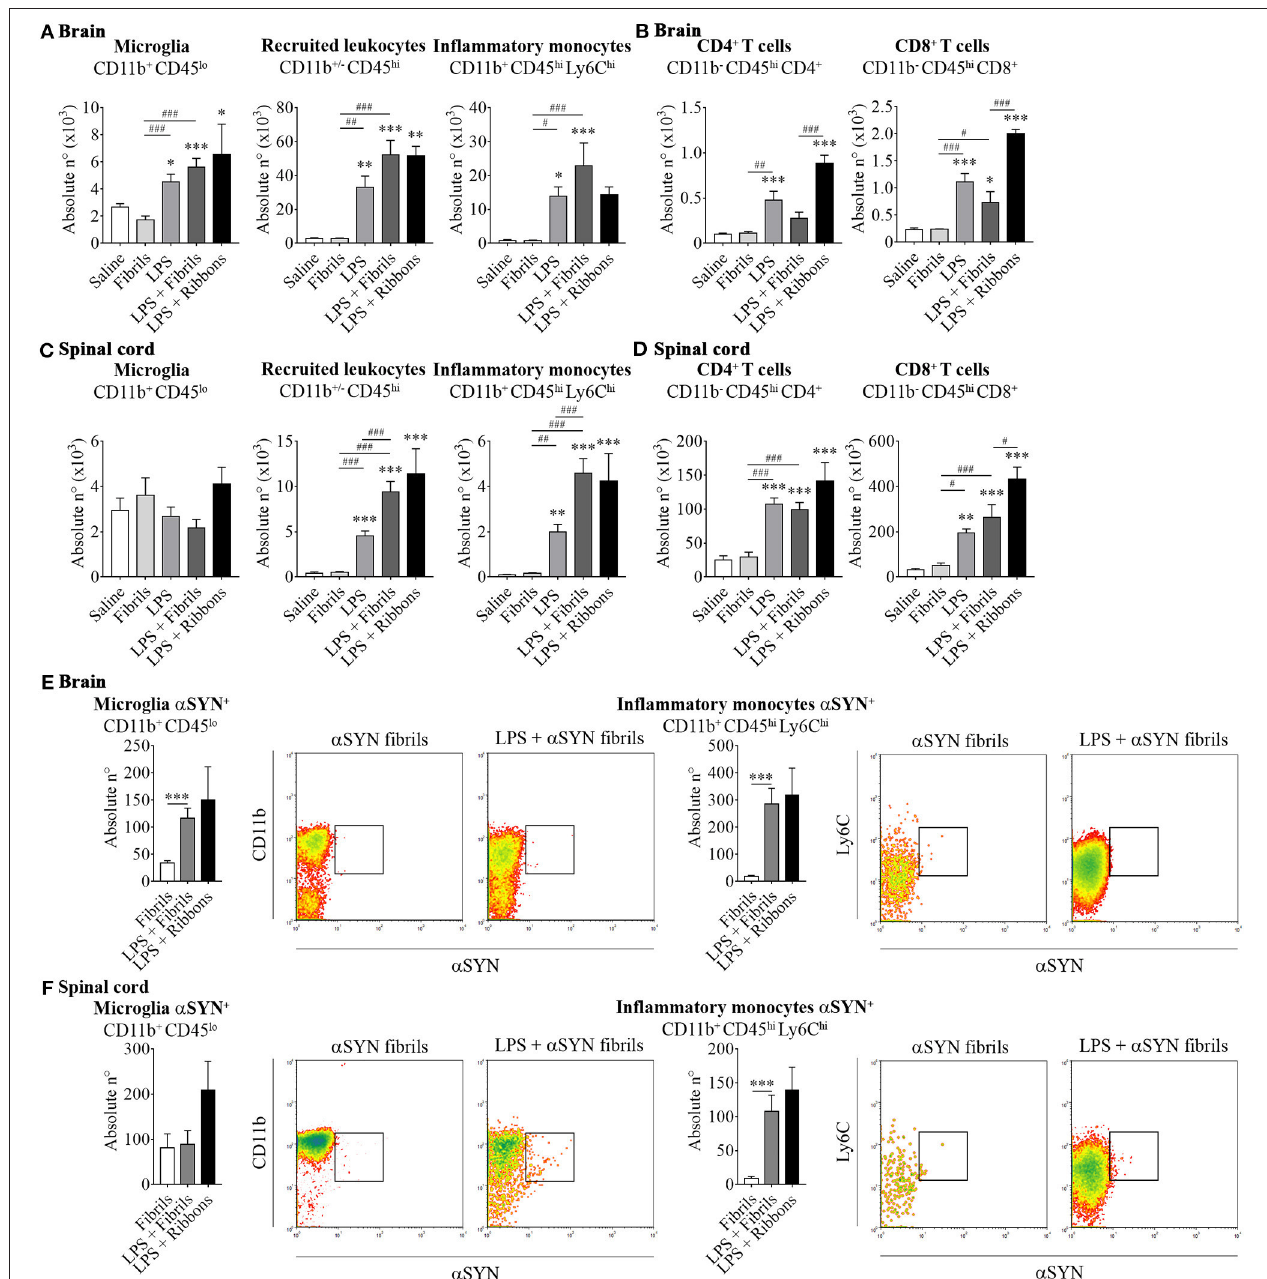
FIGURE 1 | α SYN hijacks the activation and mobilization mechanism of LPS-primed peripheral inflammatory monocytes to disseminate into the CNS . Mice were treated with either (a) 20 µ g of LPS i.p (LPS group), (b) 5 µ g of atto-488-labeled pathogenic α SYN fibrils or ribbons i.v. ( α SYN group), (c) LPS combined with α SYN strains (LPS + α SYN group), or (d) saline alone, following the administration scheme depicted in Figure 2A . Twelve hours after the last injection, mice were euthanised and immune cells were isolated from either whole brain (A,B) or spinal cord (C,D) and stained for subsequent flow cytometric analysis. Absolute numbers of CD11b + CD45 lo microglial cells, CD11b + / − CD45 hi recruited cells, CD11b + CD45 hi Ly6C hi inflammatory monocytes, CD11b − CD45 hi CD4 + and CD11b − CD45 hi CD8 + lymphocytes were assessed by flow cytometry. Absolute numbers of α SYN-internalized CD11b + CD45 lo microglial cells or CD11b + CD45 hi Ly6C hi inflammatory monocytes purified from brain (E) or spinal cord (F) , were assessed by flow cytometry. Results are representative of two independent experiments combined ( n = 3–4 animals per group). Representative CD11b vs. α SYN and Ly6C vs. α SYN density-plots illustrate the gating analysis strategy employed for microglial cells and inflammatory monocytes, when gated in CD45 lo or CD45 hi cells respectively. Data are expressed as mean ± s.e.m. Means between groups were compared with one-way analysis of variance followed by a Tukey’s post-hoc test. Statistical significance levels were set as follows: * / # if p < 0.05, ** / ## if p < 0.01, and *** / ### if p < 0.001. The asterisks indicate the comparison against the saline treated group.